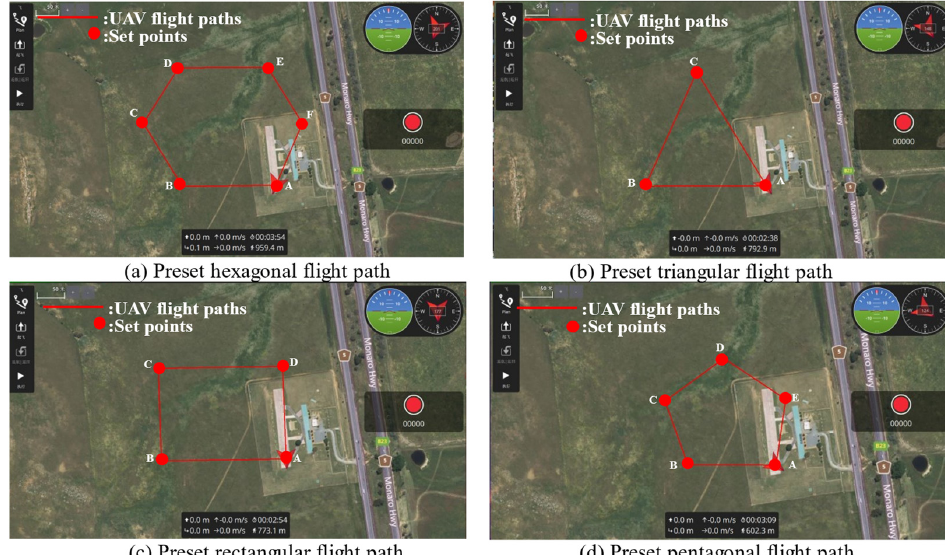
Figure 3. UAV 2D flight trajectory map.